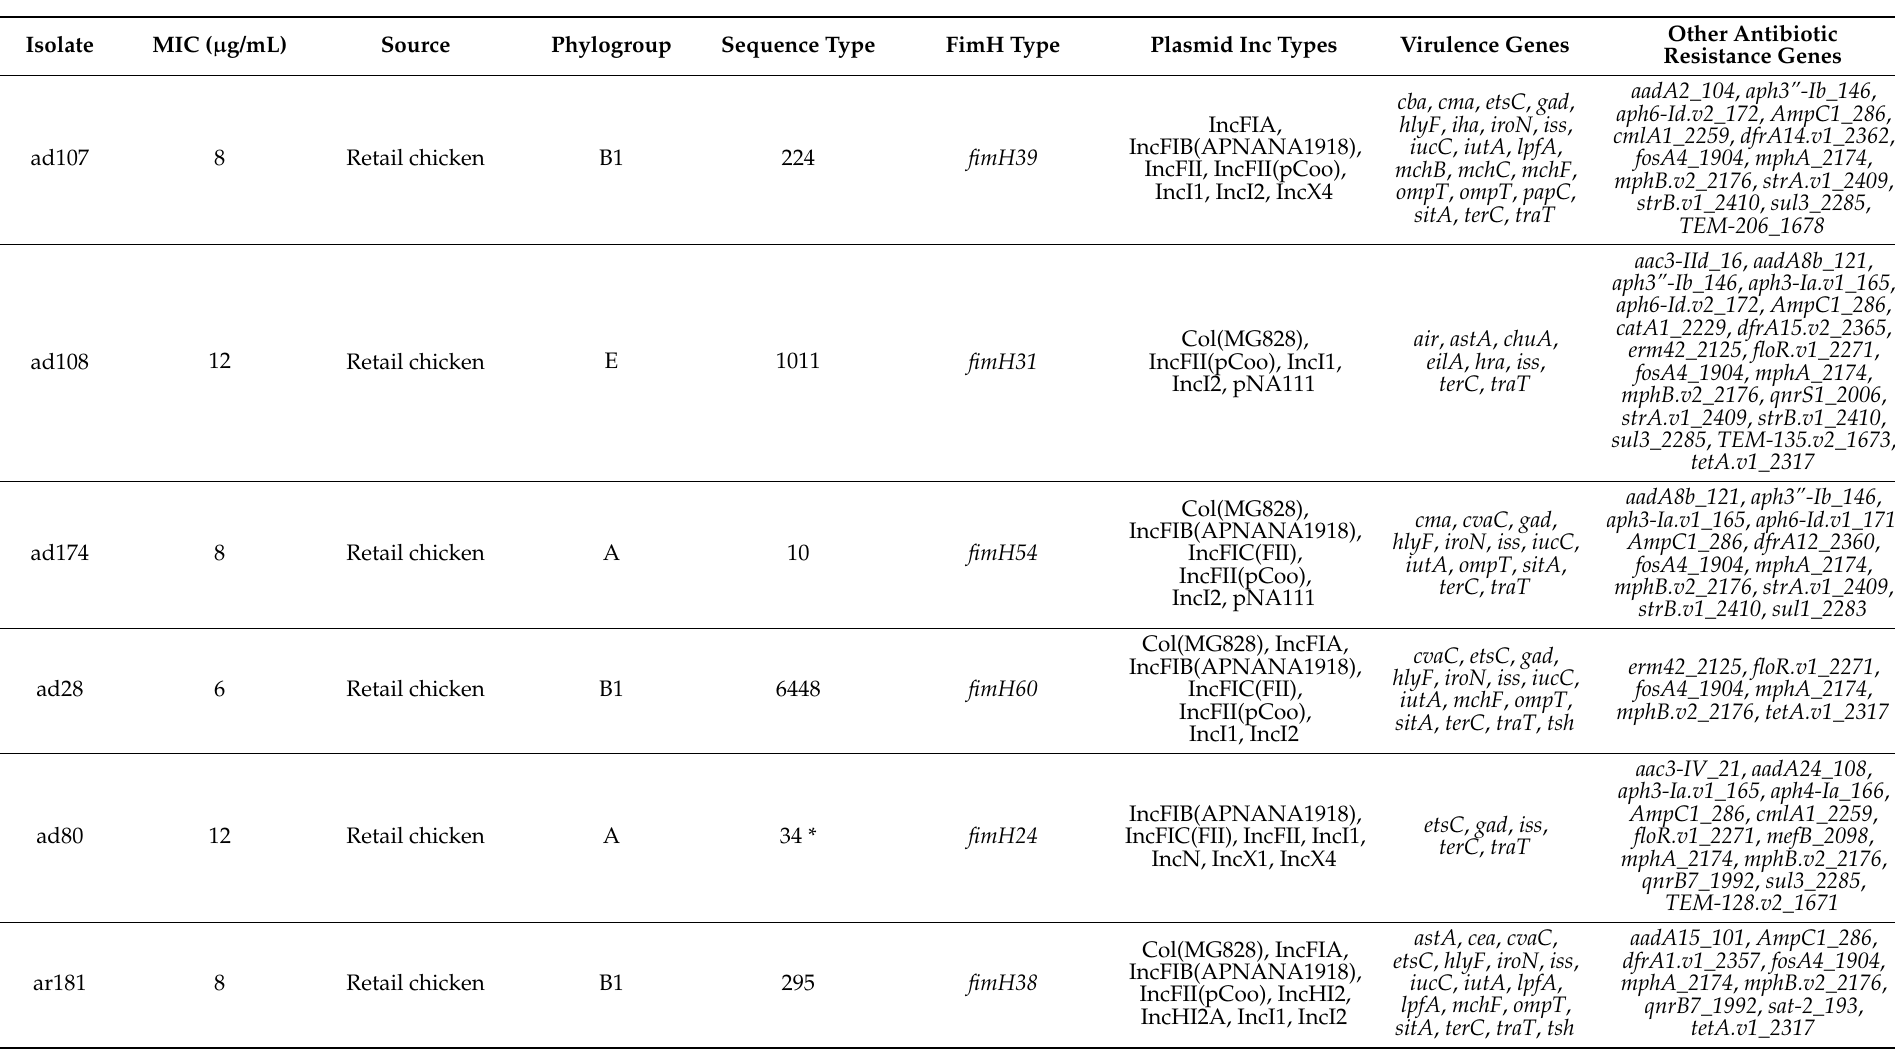
Table 1. Colistin minimum inhibitory concentrations (MICs), genomic analysis, and properties of the mcr-1 -harbouring E. coli